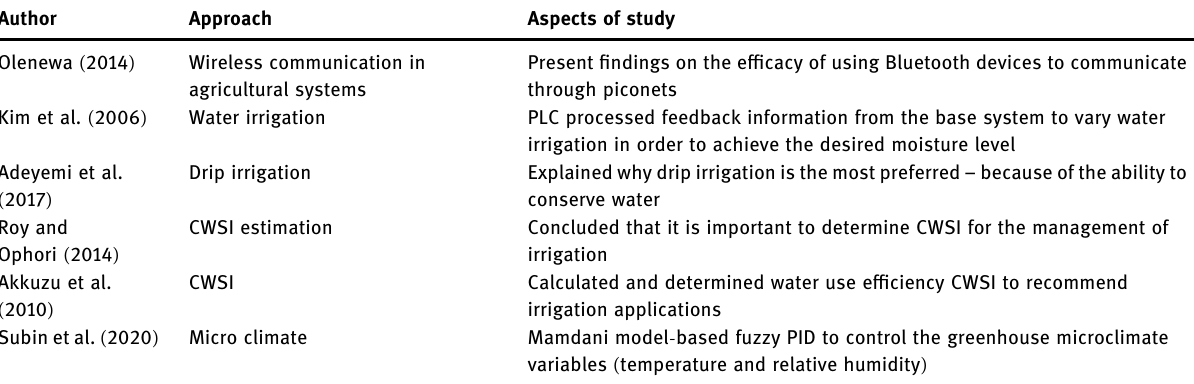
Author Aspects of study